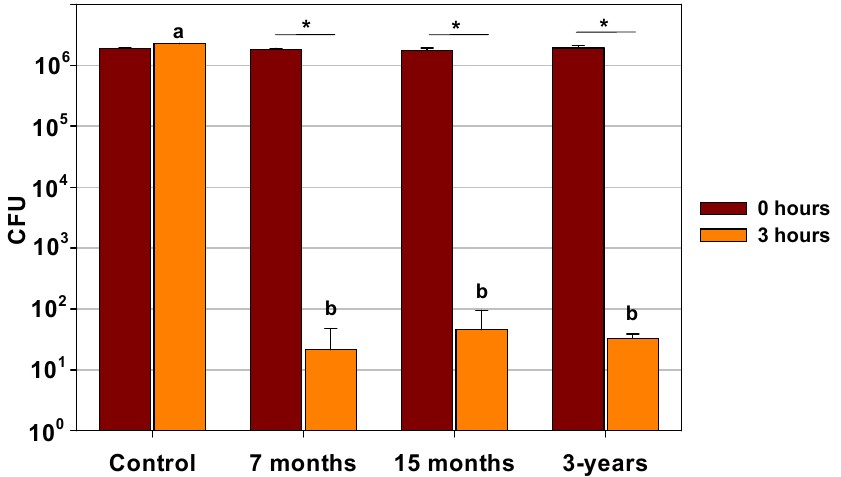
ative control dressing were examined by t -tests. * = p < 0.001.